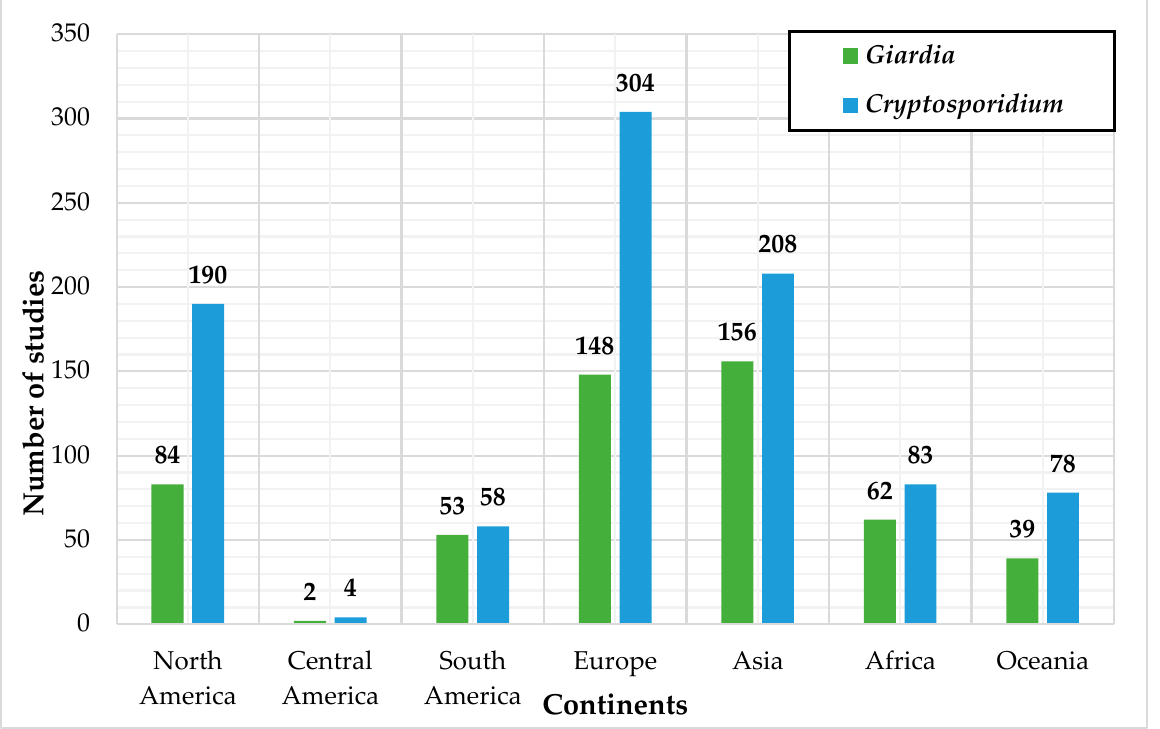
Figure 3. Origin of the water samples from biomolecular studies reviewed according to the parasite of interest.